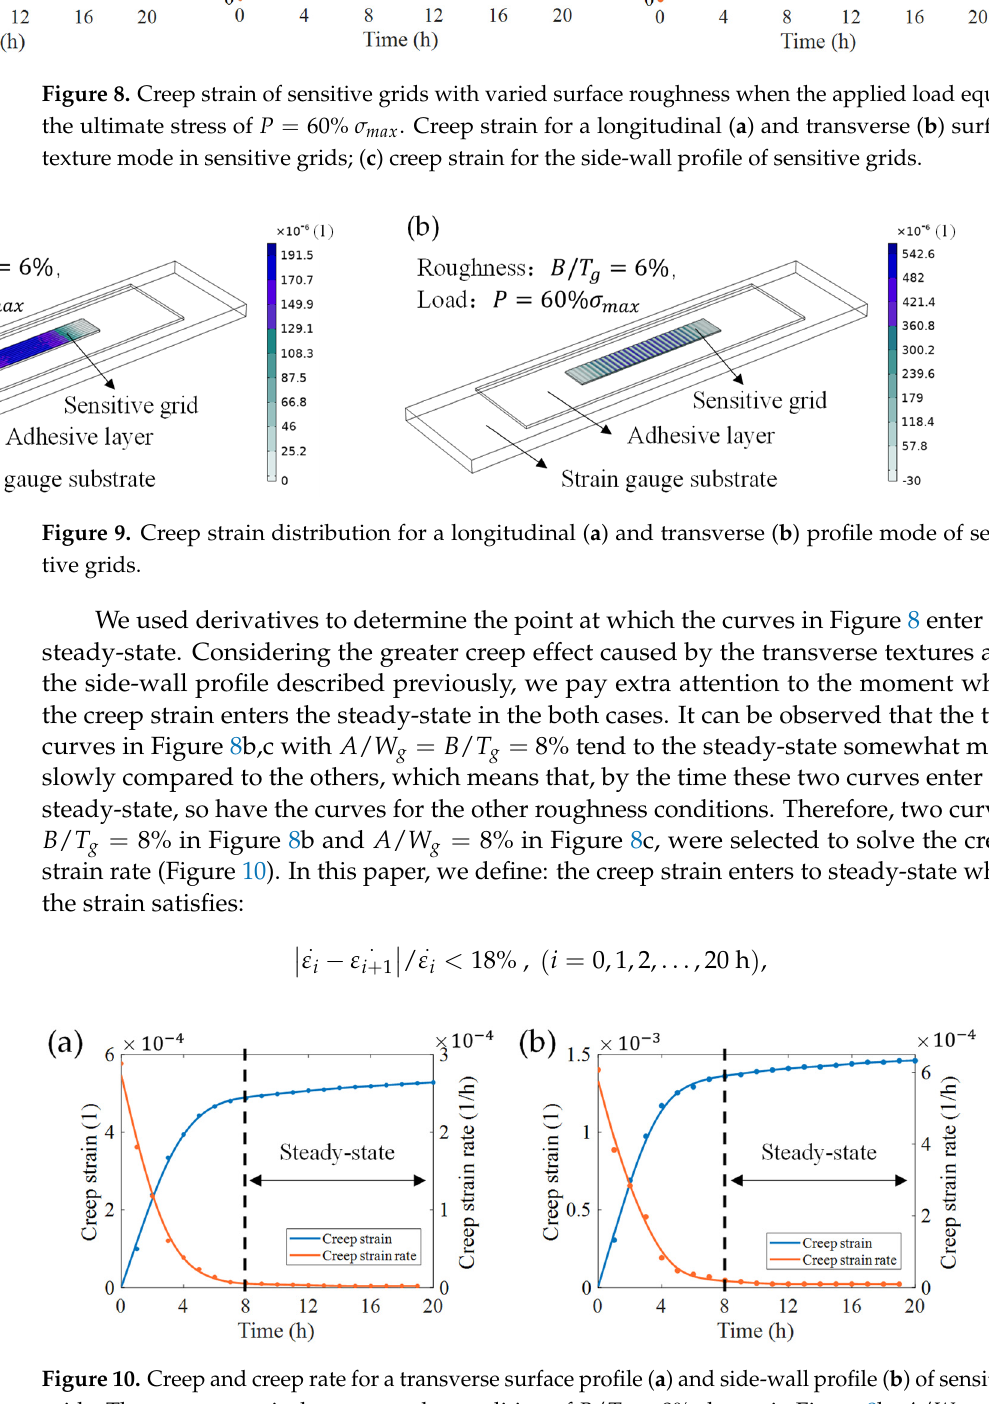
Figure 8. Creep strain of sensitive grids with varied surface roughness when the applied load equals the ultimate stress of P = 60% σ max . Creep strain for a longitudinal ( a ) and transverse ( b ) surface texture mode in sensitive grids; ( c ) creep strain for the side-wall profile of sensitive grids.